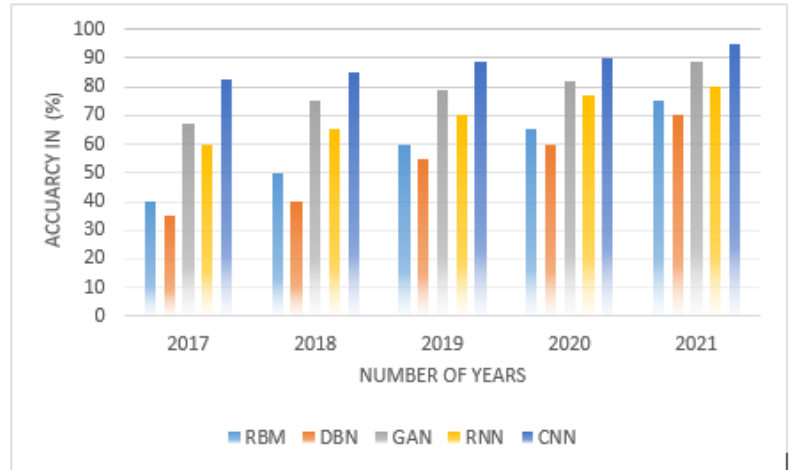
Figure 4. Performance efficiency with different deep learning